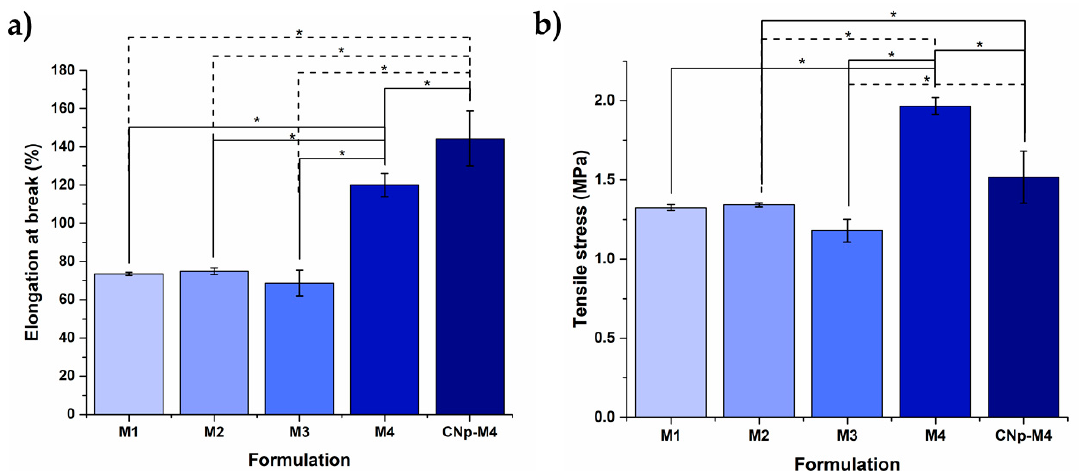
Figure 3. Effect of plasticizers on the mechanical properties of alginate membranes. Effect on mechanical properties by the addition of PVA + glycerin (M1), PVA + glycerin + propylene glycol (M2), PVP + glycerin (M3), PVP + glycerin + propylene glycol (M4), and CNp + PVP + glycerin + propylene glycol (CNp ‒ M4), respectively. ( a ) Elongation at break; ( b ) tensile stress, (mean ± SD; n = 3). * indicates p < 0.05 as statistically significant.